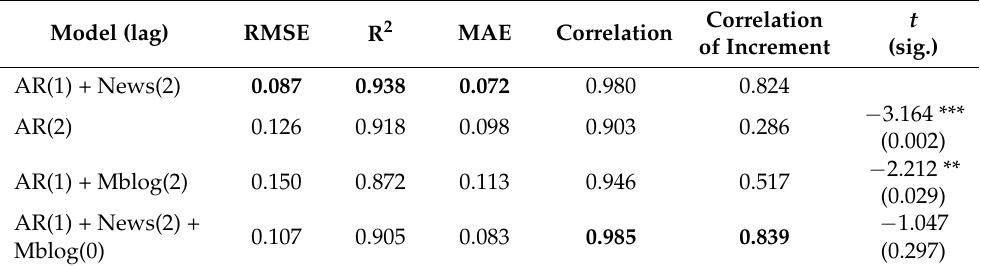
Table 1. Comparison of different models for the forecasting of influenza epidemics: south of main- land China. Model (lag) RMSE R 2 MAE Correlation